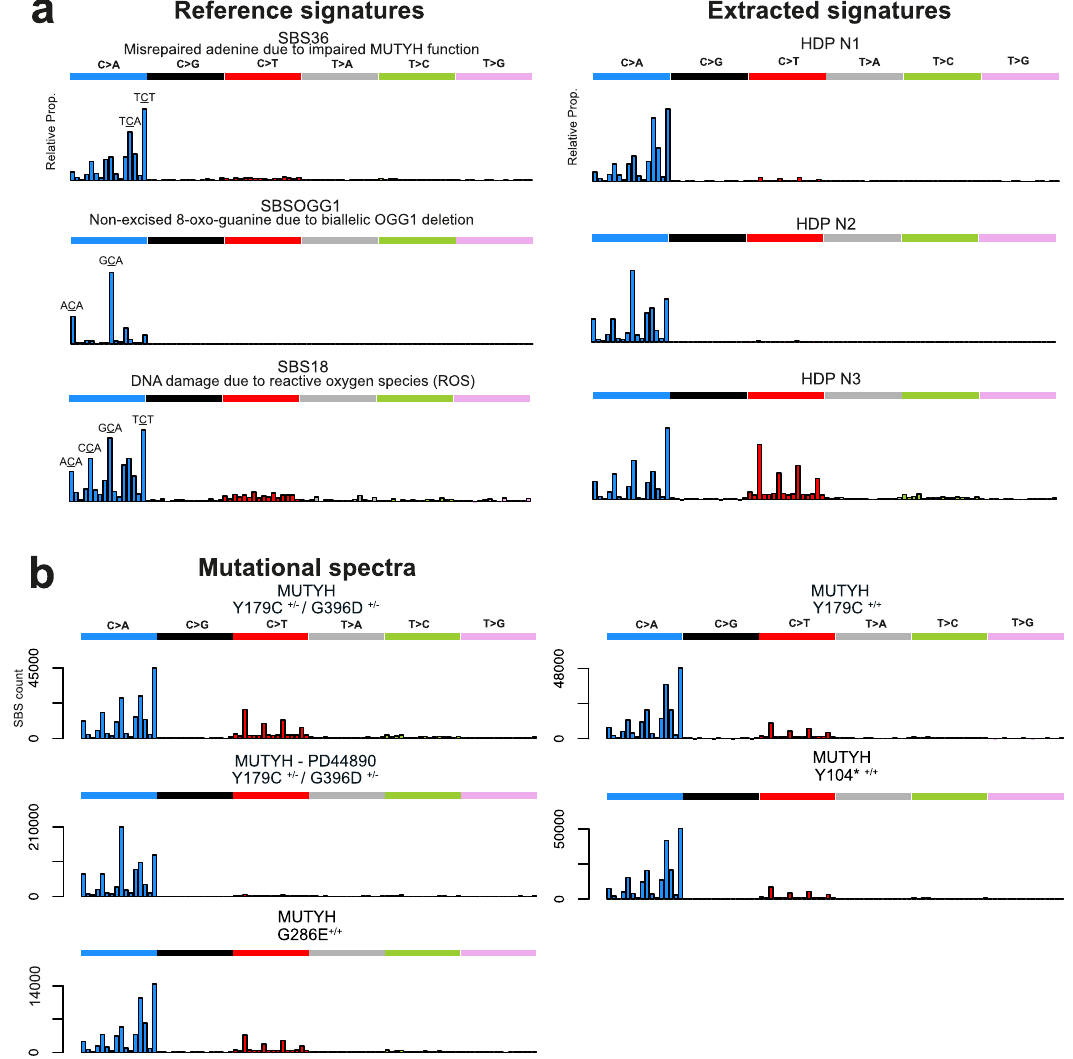
Fig. 2 Mutational spectra and signature components from normal cells with MUTYH mutations. a Probability distribution for COSMIC reference signature Single Base Substitution (SBS) signature SBS36 40 , recently described OGG1 deletion signature SBSOGG1 51 and COSMIC reference signature SBS18 40 . Mutational signature components N1-3 from Hierarchical Dirichlet Process (HDP) de novo signature extraction (see Supplementary Information for all components and Methods for further explanation). b Mutational spectra in normal tissues displayed by the germline MUTYH mutation. Aggregate mutational spectra of unique somatic mutations from normal crypts with MUTYH Y179C + / − G396D + / − ( n = 47), MUTYH Y179C + / − G396D + / − - PD44890 ( n = 38), MUTYH Y179C + / + ( n = 21), MUTYH Y104* + / + ( n = 31) and MUTYH G286E + / + ( n = 7). Distinctive peaks are annotated with their trinucleotide context (mutated base is underlined). PD44890 is displayed separately to highlight the difference in spectrum observed in this individual. Source data are provided as a Source Data fi